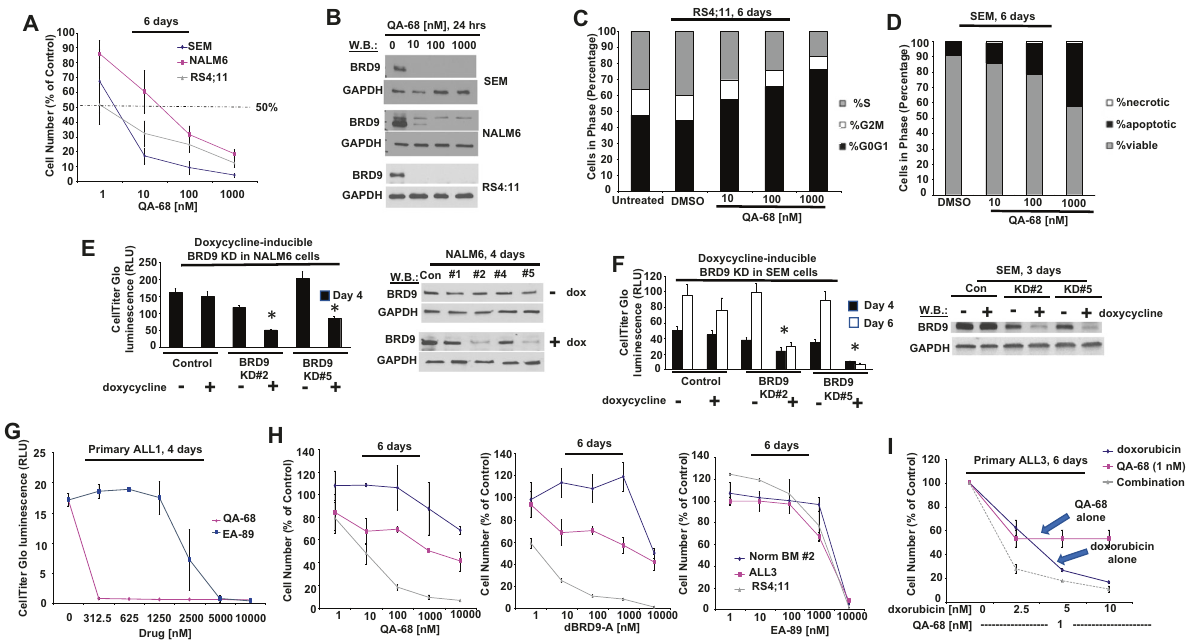
Fig. 4 Targeted loss of BRD9 protein inhibits ALL cell proliferation and cell cycle progression and decreases viability. A Proliferation assays: ALL cell lines treated with QA-68. 6-day assay. B Effects of QA-68 on BRD9 expression in ALL cell lines. 24-h assay. C Effects of QA-68 on RS4;11 cell cycle progression. 6-day assay. D Effects of QA-68 SEM cell apoptosis. 6-day assay. E , left panel Proliferation of NALM6 control cells and doxycycline-inducible BRD9 KD NALM6 cells + /-doxycycline. 4-day assay. Asterisks indicate statistical signi fi cance. t-test, 4-day: NALM6 control (-dox):NALM6 control ( + dox) ( P = 0.377); NALM6 BRD9 KD#2 (-dox):NALM6 BRD9 KD#2 ( + dox) ( P < 0.0001); NALM6 BRD9 KD#5 (-dox):NALM6 BRD9 KD#5 ( + dox) ( P = 0.0212). ( E , right panel) BRD9 expression in NALM6 control cells and doxycycline-inducible BRD9 KD NALM6 cells + /-doxycycline. F , left panel Proliferation of SEM control cells and doxycycline-inducible BRD9 KD SEM cells + /-doxycycline. 4- and 6-day assays. t-test, 4-day: SEM control (-dox):SEM control ( + dox) ( P = 0.2879); SEM BRD9 KD#2 (-dox):SEM BRD9 KD#2 ( + dox) ( P = 0.0107); SEM BRD9 KD#5 (-dox):SEM BRD9 KD#5 ( + dox) ( P = 0.0004). t-test, 6-day: SEM control (-dox):SEM control ( + dox) ( P = 0.1924); SEM BRD9 KD#2 (-dox):SEM BRD9 KD#2 ( + dox) ( P = 0.0006); SEM BRD9 KD#5 (-dox):SEM BRD9 KD#5 ( + dox) ( P = 0.0003). ( F , right panel) BRD9 expression in SEM control cells and doxycycline-inducible BRD9 KD SEM cells + /-doxycycline. DOX, 1 µg/ml; DMSO, 0.1%. G Proliferation assays: Primary ALL1 cells treated with QA-68 and EA-89 for 4 days. H Proliferation assays: Normal bone marrow cells (sample #2) and primary ALL3 cells treated with QA-68 (left panel), dBRD9-A (middle panel), or EA-89 (right panel). 6-day assay. RS4;11 cells were tested as a positive control. I Treatment of primary ALL-3 cells with QA-68 alone, doxorubicin alone, or a combination. 6-day and viability. We treated several MM cell lines with QA-68, dBRD9- derived cultures were decreased by a modest 2-fold effect A, and EA-89 and, similar to AML and ALL, we observed QA-68 or (Fig. 5B). In addition, treatment of normal peripheral blood dBRD9A to more potently inhibit cell proliferation than EA-89 with mononucleated cells (PBMCs) with QA-68 or the BRD2,3,4 a concomitant decrease in BRD9 protein (Fig. 6A, B and inhibitor, JQ1, at concentrations up to 10 μΜ showed no Supplementary Fig. 9). Cell lines, including MM.1S and H929, detectable cell loss by QA-68, while JQ1 produced a strong showed the highest sensitivity to BRD9 degrader treatment as viability phenotype (Fig. 5C). EA-89, while less toxic toward normal compared to other lines, such as U266 and 8226. QA-68- and PBMCs than JQ1, did however kill cells at higher concentrations dBRD9-A-induced cell killing correlated with BRD9 degradation, (5 – 10 μ M). Coupled with the lack of toxicity of BRD9 degrader and as observed with AML and ALL, c-MYC expression was treatment against normal bone marrow cells, our fi ndings suggest variable in response to BRD9 loss in different MM lines small molecule degradation of BRD9 is comparatively nontoxic (Supplementary Fig. 9D, F). QA-68 or dBRD9-A treatment of MM toward normal hematopoietic cells. Of note, QA-68 treatment cell lines induced modest levels of apoptosis and inhibited cell leads to degradation of BRD9, but not the JQ1 target, BRD4, in cycle progression (most apparent at 1000 nM) (Fig. 6C, D). leukemia cells, and washout of QA-68 leads to a reversal of BRD9 Doxycycline-induced BRD9 KD in H929 cells led to inhibited cell degradation effects but has no effect on BRD4 (Supplementary proliferation and inhibition of colony formation, validating BRD9 Fig. 8A, B). Taken together, these results support the selectivity of as an important target for the growth and viability of MM cells QA-68 toward BRD9 as a protein target. (Fig. 6E). Importantly, dBRD9-A selectively killed primary MM cells, QA-68 was observed to inhibit colony formation of additional with little effect on bone marrow cells from a healthy donor primary AML bone marrow and PBMC cells (Fig. 5D, E). (patient details provided in Supplementary Table 1) (Fig. 6F). Interestingly, despite QA-68 and 5-azacytidine showing little potency against one primary AML sample (AML14) as single agents, the combination of QA-68 and 5-azacytidine was more ef fi cacious, resulting in a leftward shift of the dose-response curves (Fig. 5F). Targeted loss of BRD9 protein in MM inhibits cell growth, viability, cell cycle progression, and colony formation We were interested in investigating other hematopoietic malig- nancies to determine what role, if any, BRD9 may play in growth